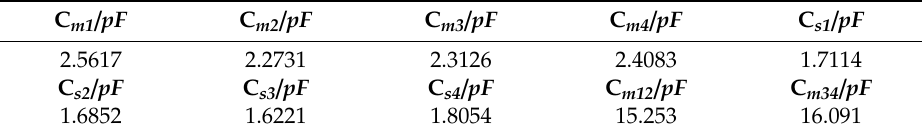
Table 2. The capacitance value of the Dual-Differential D-dot sensor.